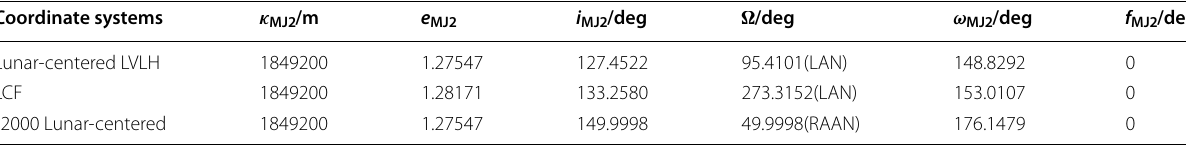
Table 5 The lunar‑centered modified classical orbital elements with the high‑precision model at LOI epoch Coordinate systems LCF